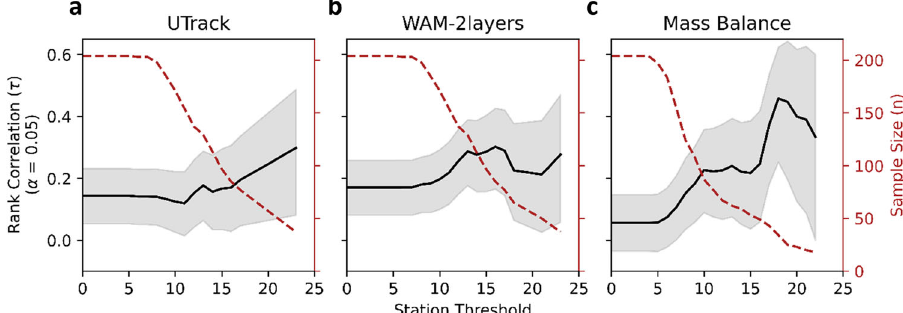
Fig. 5 Station sample size analysis. Kendall ’ s Tau rank correlation is computed between mean d-excess and precipitation recycling estimates across all tropical stations and for each recycling model for the monthly time-series from 2002 to 2018. The average correlation coef fi cient (black solid line) and corresponding 95% con fi dence interval (solid gray fi ll) are constructed for each minimum station sample size value. The corresponding sample size is reported (brown dashed line) for each